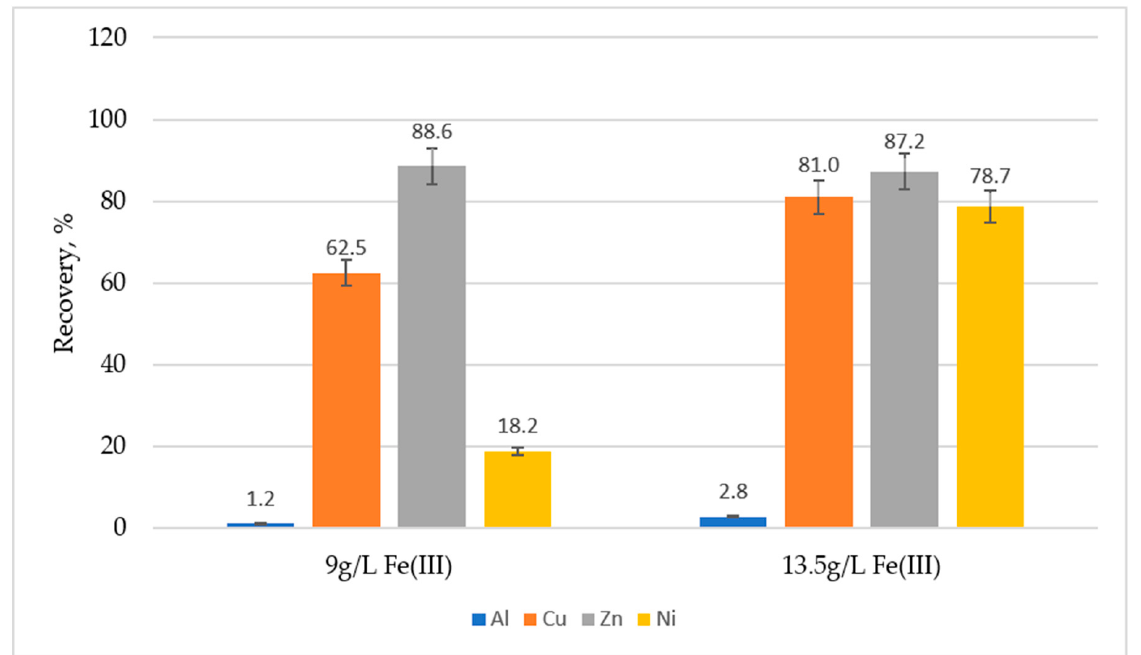
Figure 3. Recovery of metals from PCBs at 9 g/L and 13.5 g/L of biogenic Fe 3+ (PD 1%; initial pH 2.1; 40 °C; air 1 lpm; 600 rpm; duration 24 h). 2.1; 40 ◦ C; air 1 lpm; 600 rpm; duration 24